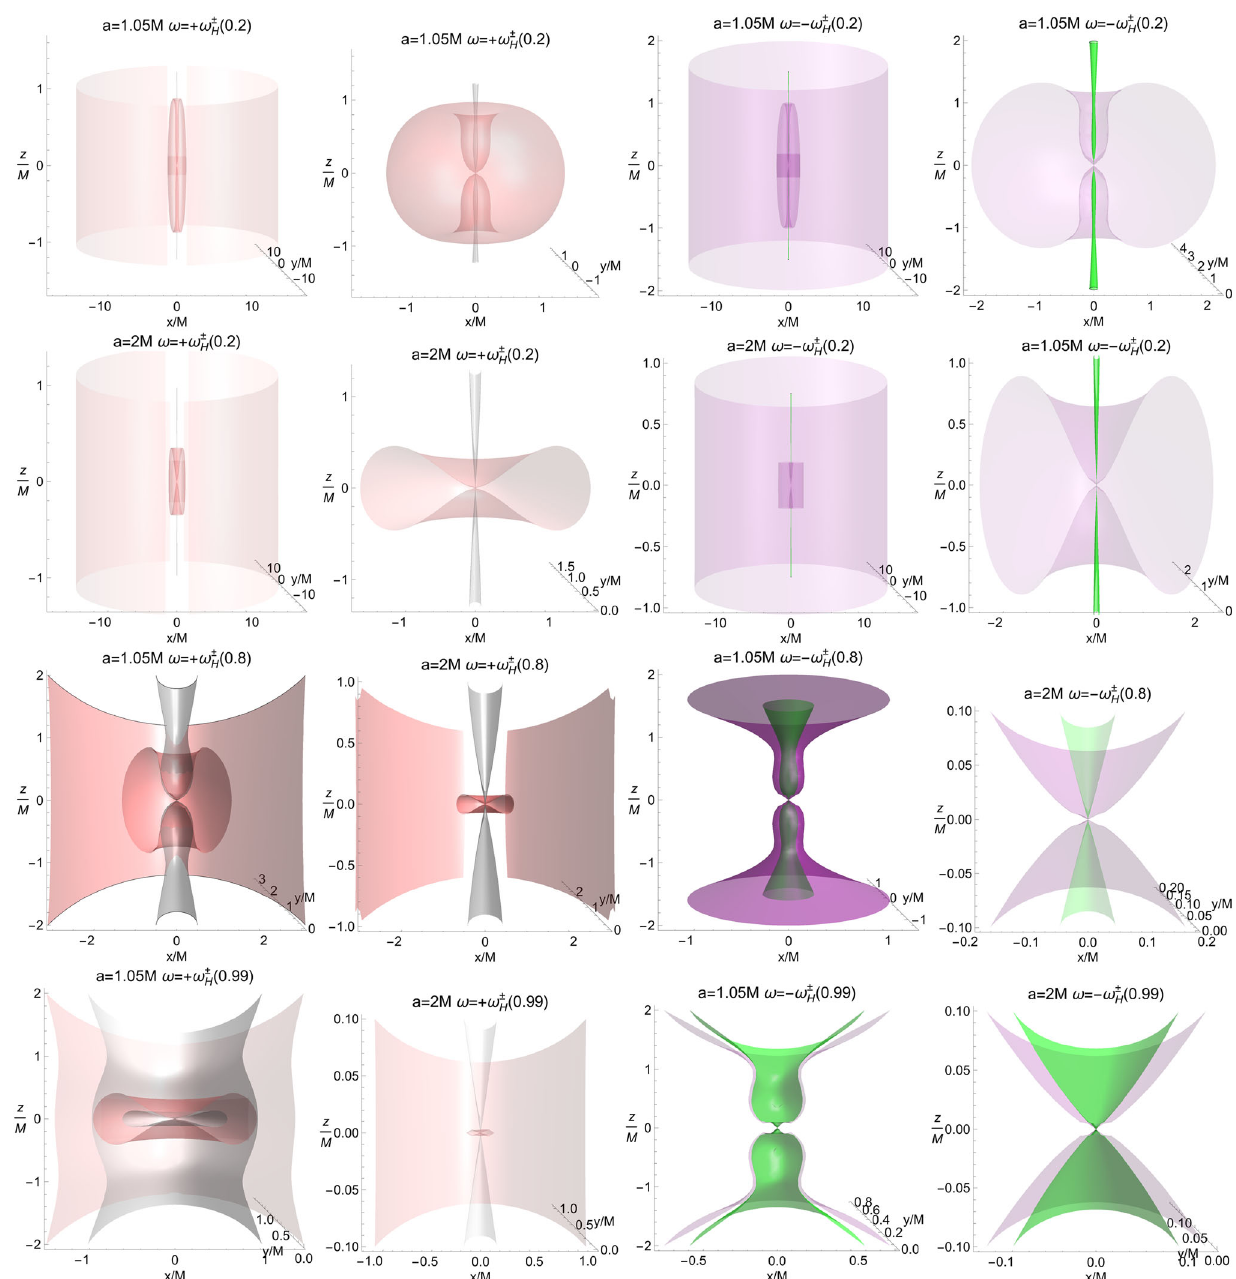
Fig. 3 Replicas of the BH horizons represented in Fig. 2 for differ- surfaces correspond to the outer horizon counter-rotating replicas (with ( a ∗ ) ). Green surfaces correspond to inner horizon ent values of a / M corresponding to naked singularities. Here, { z = frequency ω = − ω + H ( a ∗ ) ). The second r cos θ, y = r sin θ sin φ, x = r sin θ cos φ } . The central singularity is counter-rotating replicas (with frequency ω = − ω − H the point x = 0 , y = 0 , z = 0. ω ± are the outer and inner BH horizon and fourth columns are close-up views of the first and third columns, H frequencies, respectively. Co-rotating outer and inner horizon replicas respectively. They show the innermost replicas (the outermost surfaces ( a ∗ ) and counter-rotating outer and inner with frequency ω = + ω ± are not included for graphic reasons). Some surfaces are embedded in H ( a ∗ ) for the BH spacetime with spins a ∗ are horizon replicas ω = − ω ± the outermost replicas. The presence of a bottleneck region is clear in H the NS spacetime with a = 1 . 05 M (third and fourth rows). In this case, shown. Pink surfaces correspond to the outer horizon co-rotating repli- ( a ∗ ) ). Grey surfaces denote the inner the close-up view highlights the emergence of the cas (with frequency ω = + ω + H ( a ∗ ) ). Purple horizon co-rotating replicas (with frequency ω = + ω − H